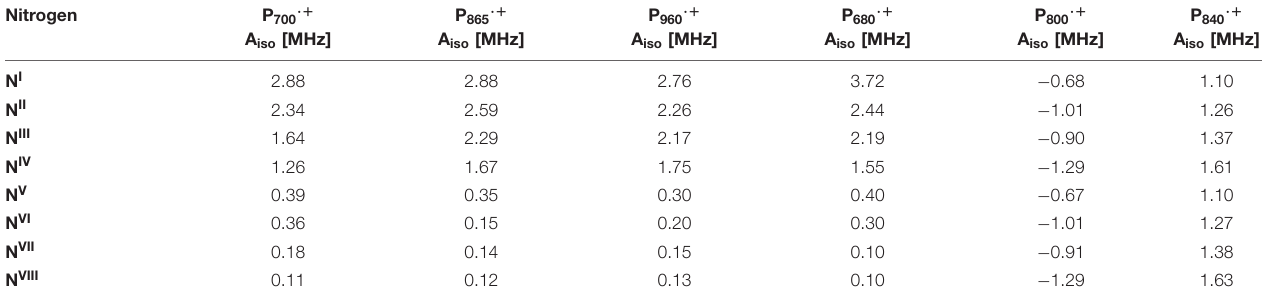
TABLE 3 | Calculated 14 N isotropic hyperfine coupling parameters of the nitrogen atoms of P 700 ·+ , P 865 ·+ , P 960 ·+ , P 680 ·+ , P 800 ·+ , P 840 ·+ (of the GsbRC).